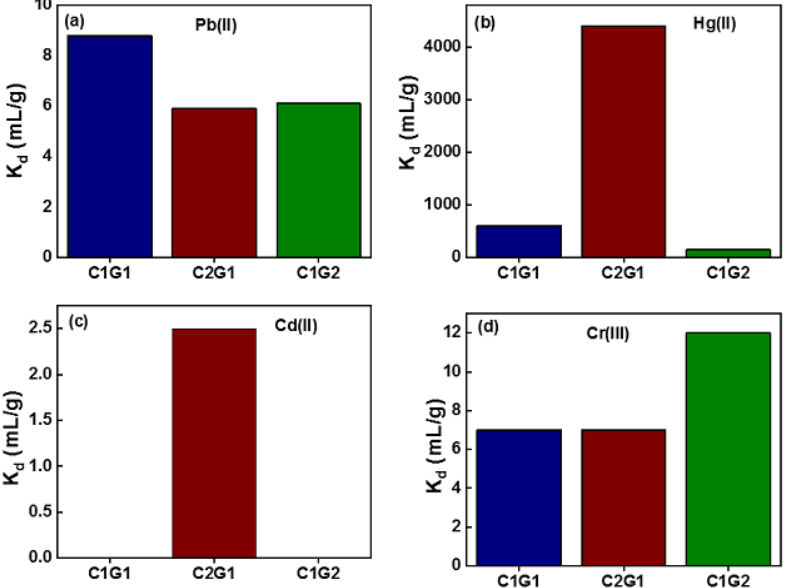
Figure 8. K d values for oven-dried hydrogel particles C1G1, C2G1, and C1G2 in single metal ion solutions of ( a ) Pb(II), ( b ) Hg(II), ( c ) Cd(II), and ( d ) Cr(III). Figure adapted from Ref. [261].